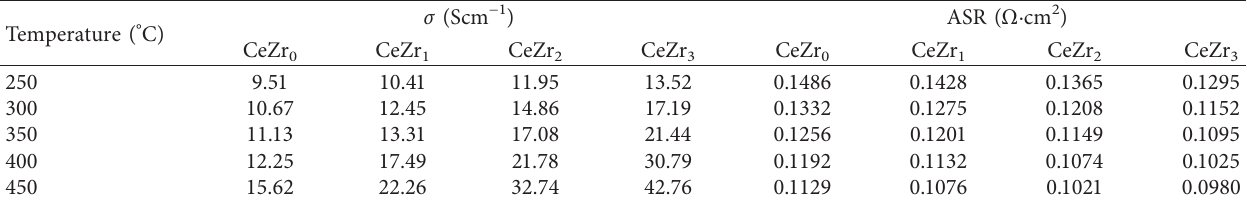
Figure 4: Temperature dependence of area specific resistances (ASRs) of prepared samples. Table 3: Electrical conductivities and area specific resistances of the prepared